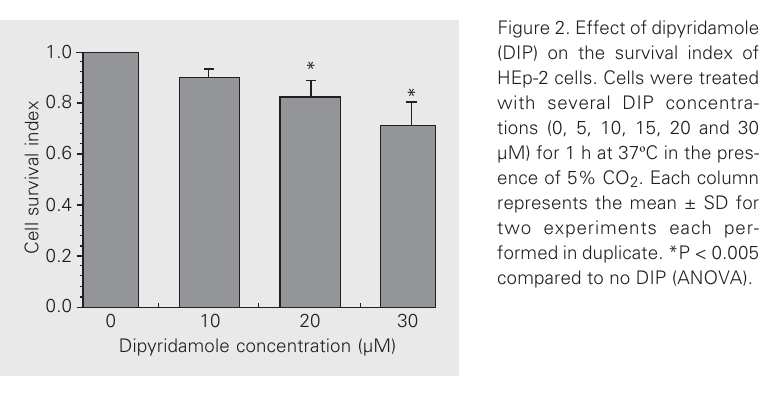
Table 2. Combination indexes for cisplatin and dipyridamole (DIP) in the HEp-2 cell line obtained by the median effect analysis. Cisplatin (µM) DIP concentration